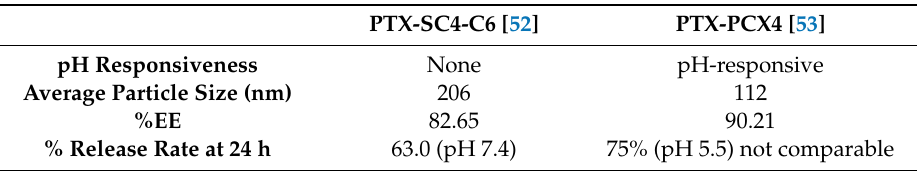
Table 2. The di ff erences between paclitaxel- tetrahexyloxy-p-sulfonato calix[4]arene (PTX-SC4-C6) and paclitaxel- phosphonated calix[4]arene (PTX-PCX4) in terms of pH responsiveness, average particle size, %EE and % release rates at 24 h.